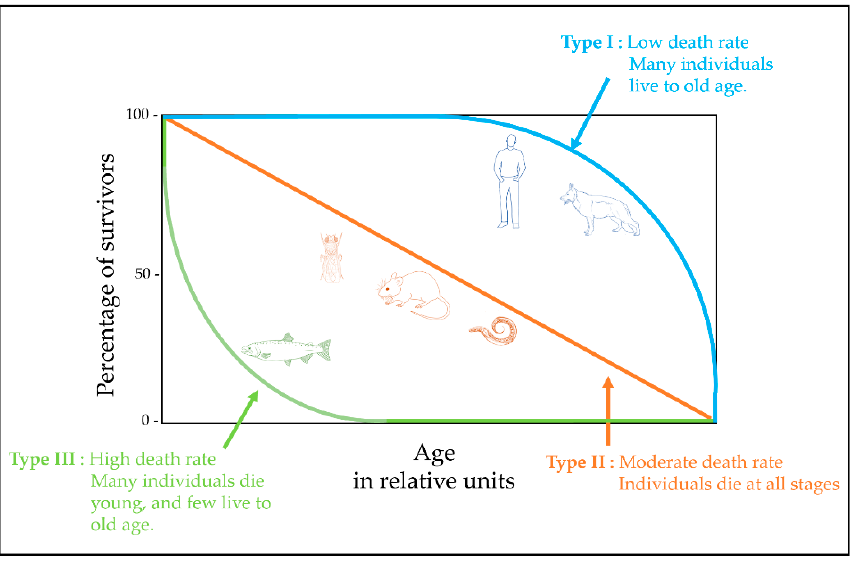
Figure 2. Survivorship curves. Adapted from Holtze S. et al. [96].